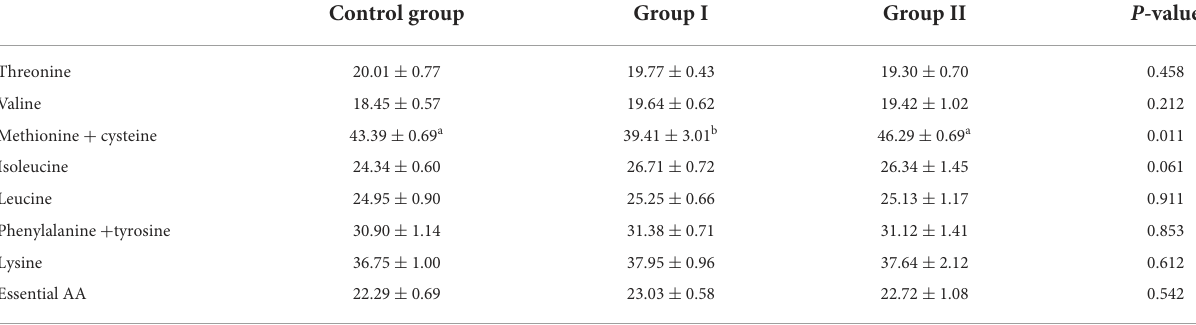
TABLE 8 Effect of dietary protein level on essential amino acid levels in the muscle of finishing